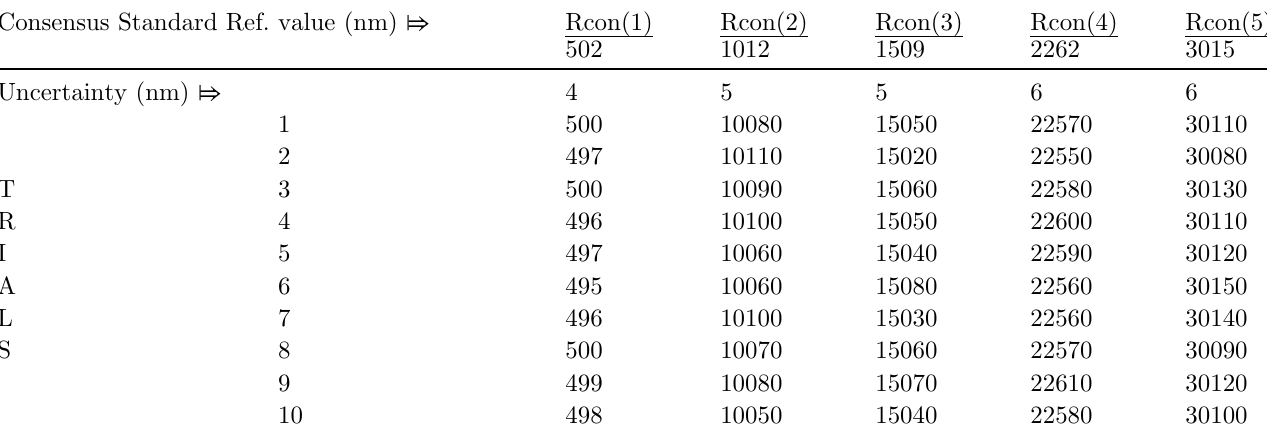
Table 8. Example 5. FAC-1; measurement system C; linearity study.